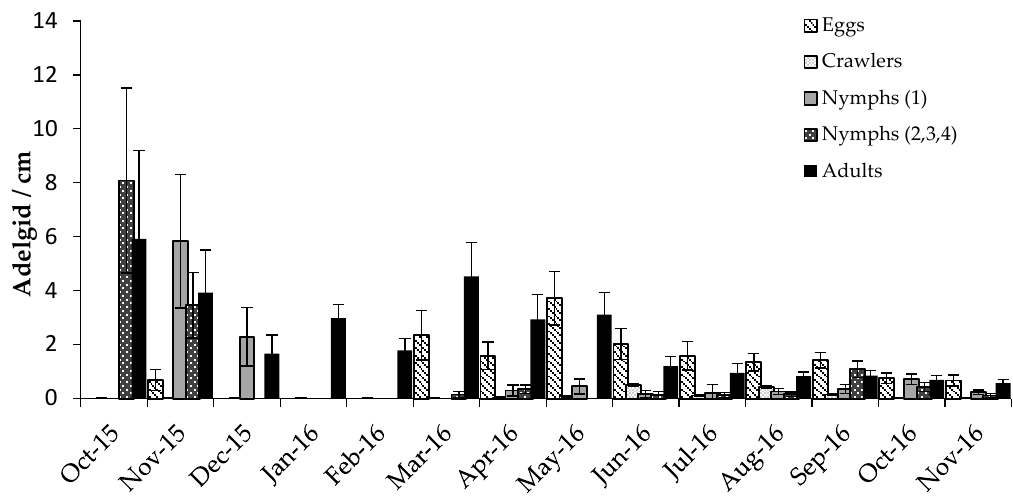
Figure 5. Mean number (±SE) of Pineus pini collected by lifestage from Pinus contorta in Tacoma, WA,